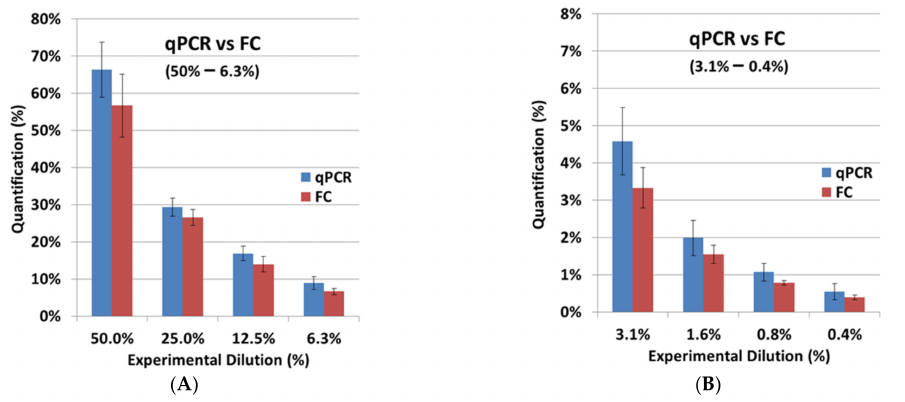
Figure 6. Comparison of quantification via qPCR with flow cytometry (FC). Graphical analysis of data from Table 2 (experimental dilution range of 50–0.4%). BCMA-CAR-T-cells were serially diluted 1:1 into non-transduced T cells of the same donor. A portion of each cell sample was used for extraction of genomic DNA and subsequent qPCR measurement. Another portion was applied to staining and flow cytometry. ( A ) Experimental dilution ranges from 50 to 6.3%. ( B ) Experimental dilution ranges from 3.1 to 0.4%. Three independent experiments were performed with cell material from different healthy donors (HD-1, HD-2, HD-3); bars with mean ± standard deviation (SD) are